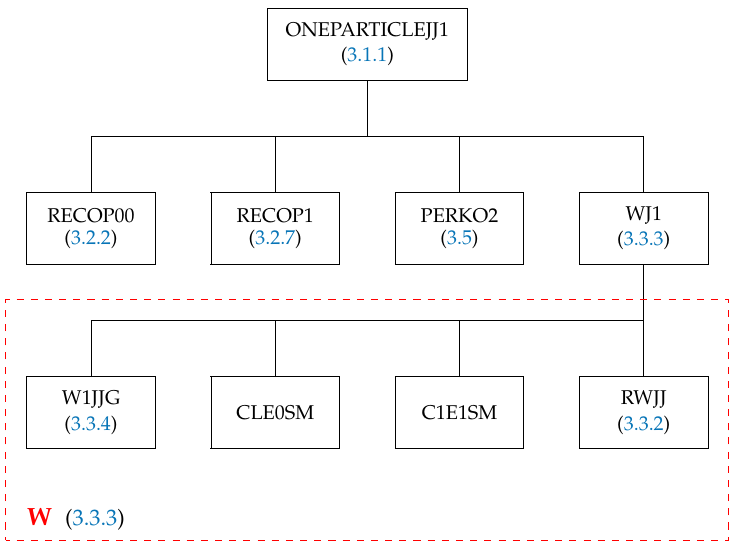
Figure 1. Structure of the subroutine ONEPARTICLEJJ1 . The red frame W shows the structure of the routine WJ (computes the matrix element (91)) to which the subroutine ONEPARTICLEJJ1 explicitly is calling. The numbers in round brackets in the separate boxes such as (Section 3.2.2) in box RECOP00 refer to the subsection number in which the subroutines are described in detail. The same notations/conventions are used in the Figures